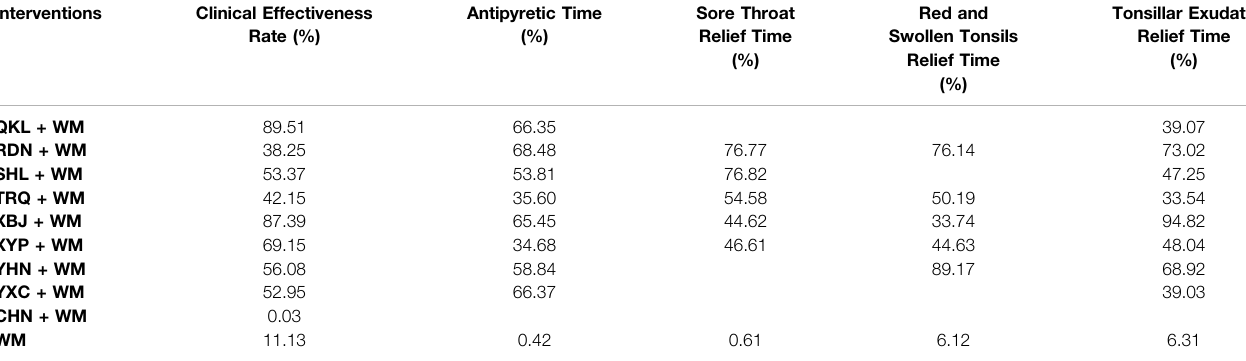
TABLE 2 | Ranking probabilities of surface under the cumulative ranking area curves (SUCRA) for fi ve outcomes. Interventions Clinical Effectiveness Rate